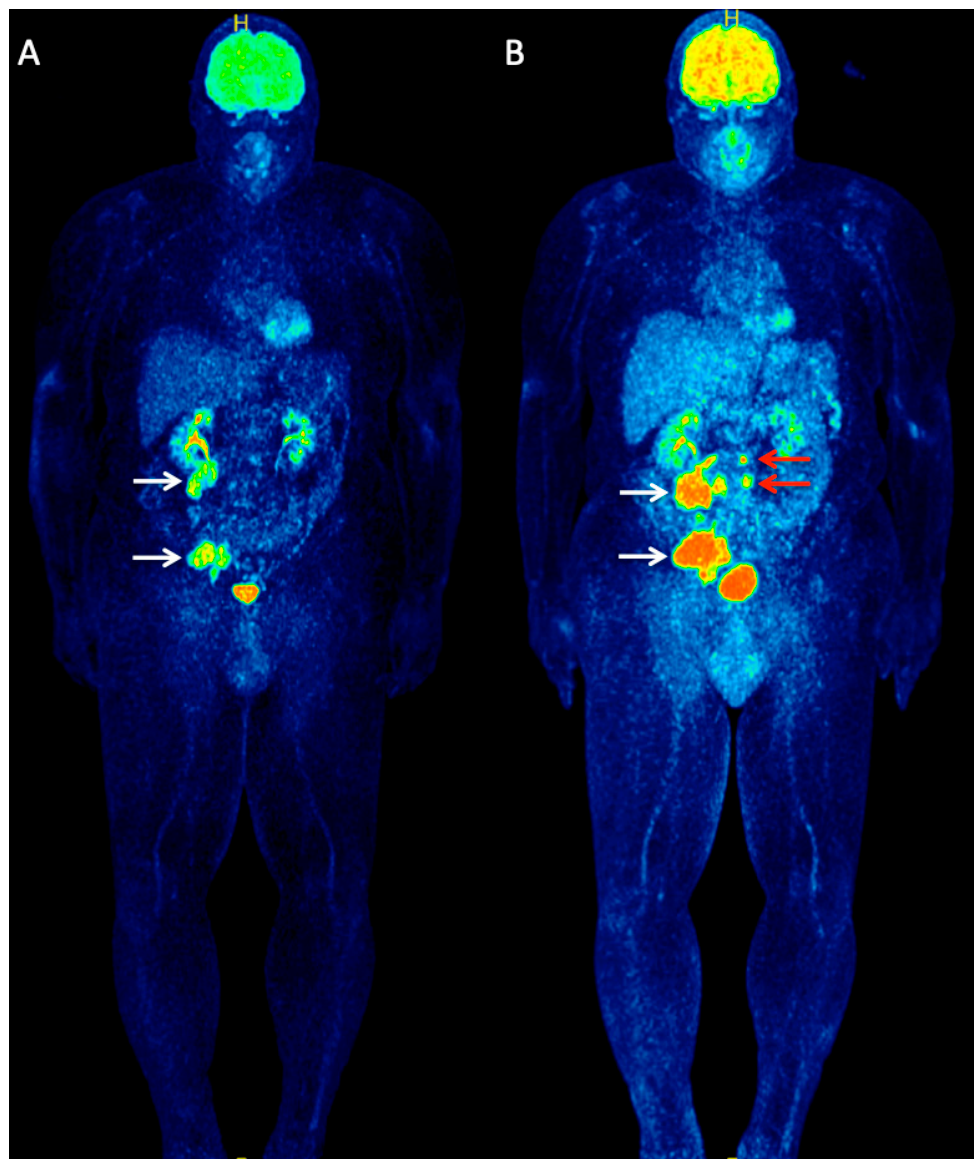
Figure 3. A 56-year-old patient with metastatic MCC of unknown primary referred to our department for staging purposes before initiation of immunotherapy. Whole-body 18 F-FDG PET (MIP) ( A ) demonstrated two large hypermetabolic lesions in the abdomen and pelvis, corresponding to lymph node metastases (white arrows). The patient received treatment with the cytotoxic T-lymphocyte-associated protein 4 (CTLA-4) inhibitor, ipilimumab, considered at the time of scanning as a potentially beneficial immunotherapeutic agent for MCC. After receiving two cycles of ipilimumab, the patient underwent an interim follow-up 18 F-FDG PET/CT for early treatment response evaluation. Whole-body 18 F-FDG PET (MIP) ( B ) revealed a clear disease progression with an increase in size and metabolism of the previously observed metastases (white arrows) but also detected newly appeared metastatic retroperitoneal lymph nodes (red arrows).